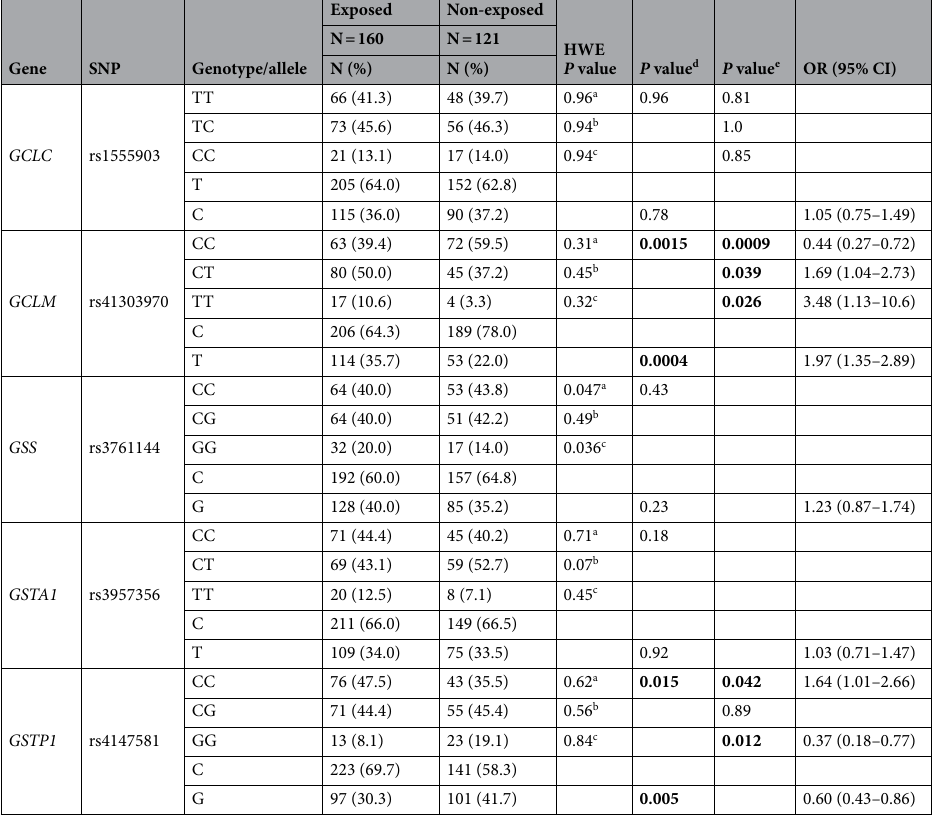
Table 2. Distribution of genetic variants in glutathione-related genes in Hg exposed and non-exposed groups. Statistically significant association are shown in bold (P value < 0.05). The statistical significance was determined using Pearson’s Chi-square test with P value simulated from 2000 permutations. P value for Hardy–Weinberg equilibrium in exposed a and non-exposed b groups, and all samples c . d P value for allele and genotype associations. e P value for each genotype versus the other two genotypes.